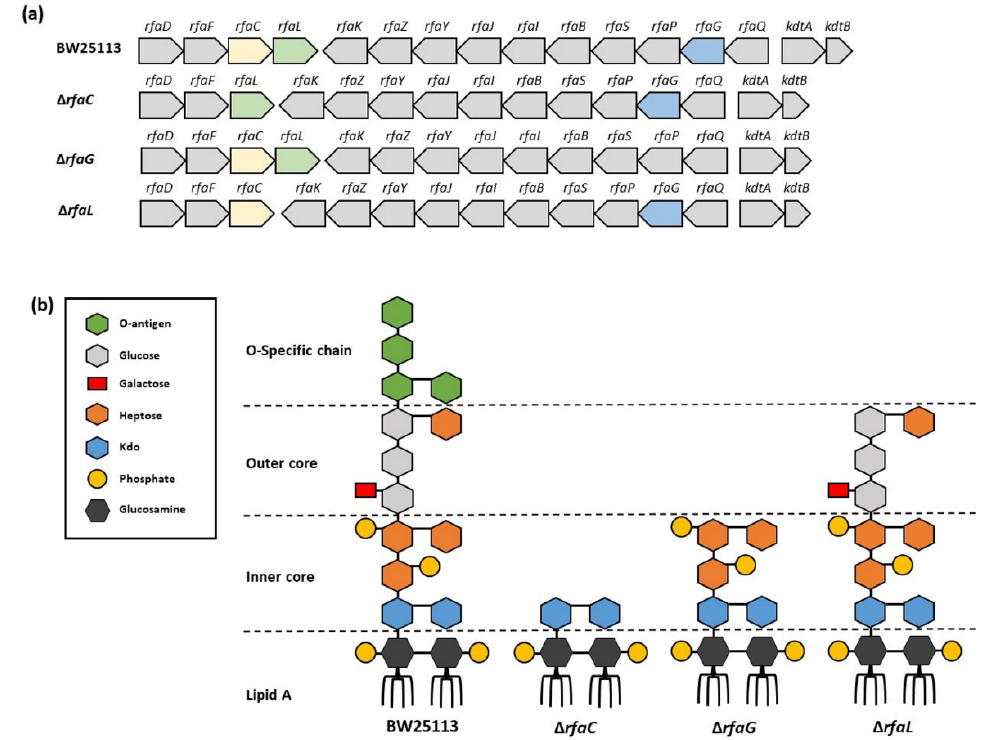
Figure 1. Lipopolysaccharide (LPS) architecture of OMVs. ( a ) OMV gene organization of E. coli BW25113, rfaC knockout (Δ rfaC ), rfaG knockout (Δ rfaG ), and rfaL knockout (Δ rfaL ) strains, respectively; ( b ) LPS architecture of OMVs of E. coli BW25113, rfaC knockout (Δ rfaC ), rfaG knockout (Δ rfaG ), and rfaL knockout (Δ rfaL ) strains, respectively. This figure is adapted from Pragnout et al.